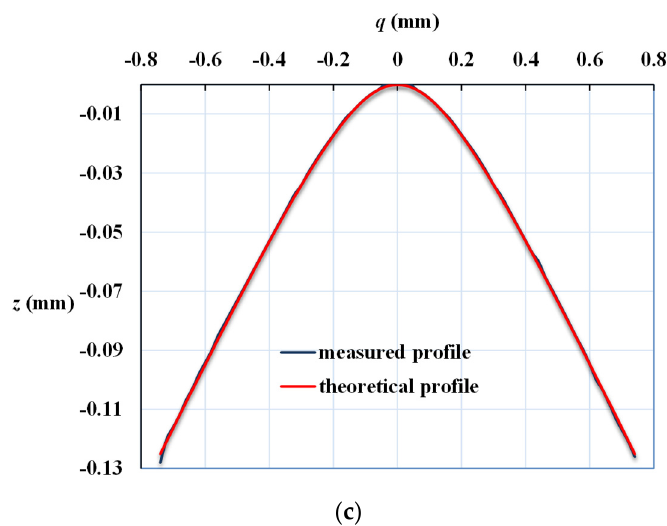
Figure 10. Comparison of machined curved surface profiles with theoretical conic section profiles calculated from Equation (8). ( a ) Oblate ellipsoid ( R = 3 mm, k = 10), ( b ) paraboloid ( R = 1 mm, k = − 1), and ( c ) hyperboloid ( R = 1 mm, k = − 20).